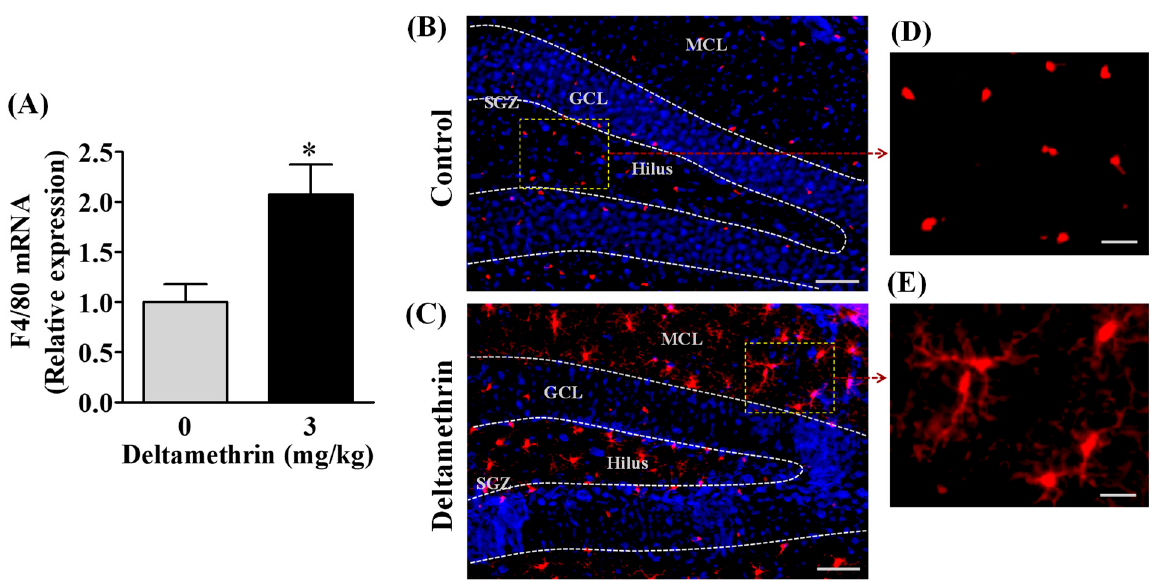
Figure 2. Repeated exposure to deltamethrin induces microglial activation and increases F4/80 mRNA in the hippocampi of adult mice. ( A ) mRNA expression of hippocampal F4/80. Asterisk denotes significant difference from control ( p < 0.05). ( B ) Microglia in resting condition in corn oil control (top panel), and ( C ) activated microglia in deltamethrin-treated mice (bottom panel). GCL, granule cell layer; SGZ, sub granular zone; MCL, molecular cell layer. Scale bar = 400 µm. Higher magnification images show representative Iba1+ cells from control animals ( D ) and deltamethrin-treated mice ( E ). Scale bar = 50 µm.